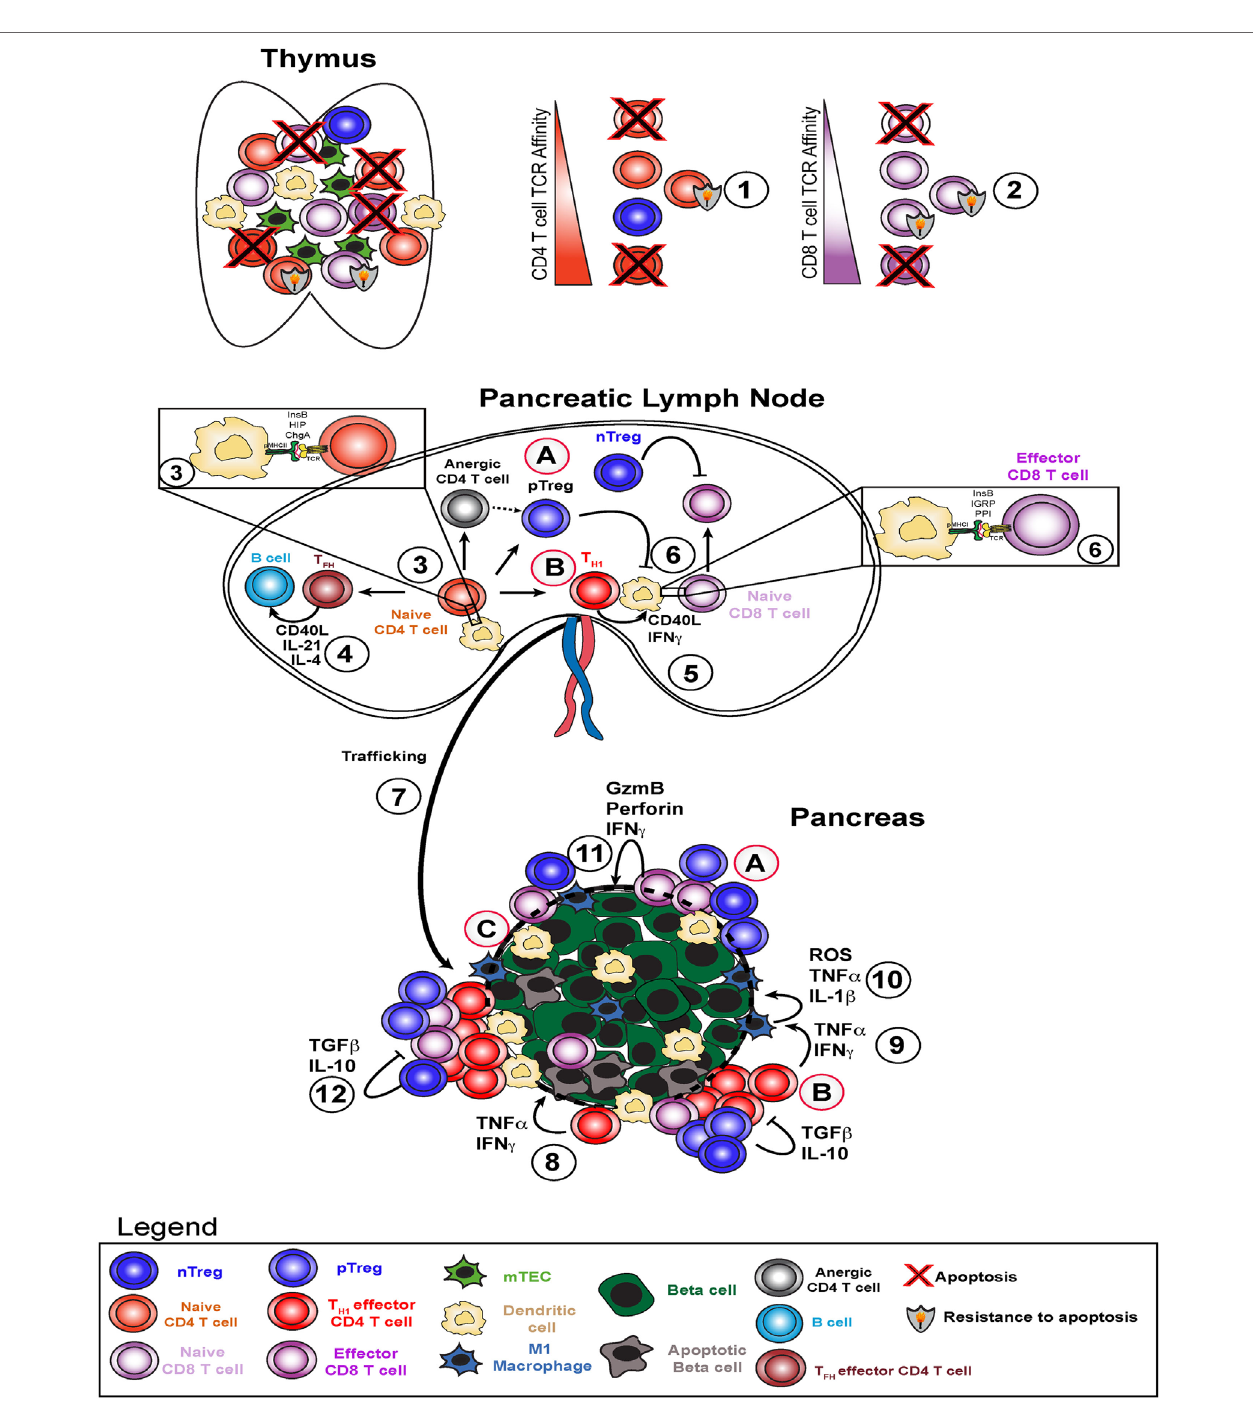
FiGURe 1 | Type 1 diabetes pathogenesis and potential therapeutic avenues. Type 1 diabetes arises due to failure of several key checkpoints. Defective central tolerance (1 and 2) allows islet-reactive CD4 and CD8 T cells to escape the thymus as naive cells and reach the pancreatic lymph node. In the pancreatic lymph node, autoreactive CD4 T cells interact with dendritic cells presenting islet antigen (3) and can become T helper 1 (T H1 ), T FH , pTreg, or anergic cells. T FH cells help B cells produce high affinity islet-specific antibodies (4). T H1 cells activate dendritic cells and enhance antigen presentation to islet-specific CD8 T cells (5) to induce effector CD8 T cell skewing (6). T H1 cells traffic to the pancreas (7), secrete pro-inflammatory cytokines interferon gamma (IFN γ ) and TNF α , and induce beta cell death (8). T H1 -derived IFN γ and TNF α stimulate M1 macrophages in the islets to produce ROS, TNF α , and IL-1 β (9), which in turn amplify beta cell death cycle (10). Resulting inflammation leads to increased CD8 T cell infiltration and direct beta cell killing via perforin and granzyme B (11) and attempts by nTregs and pTregs to dampen this response via TGF β and IL-10 (12). Potential therapeutic strategies include (A) infusion of ex vivo expanded (broadly reactive or pancreas-specific) Tregs, (B) re-educating T H1 cells through approaches like peptide-linked apoptotic splenocytes, and (C) promoting beta cell-intrinsic expression of defense molecules in situ or engineering transplanted beta cells to be more resistant to T cell-mediated attack.